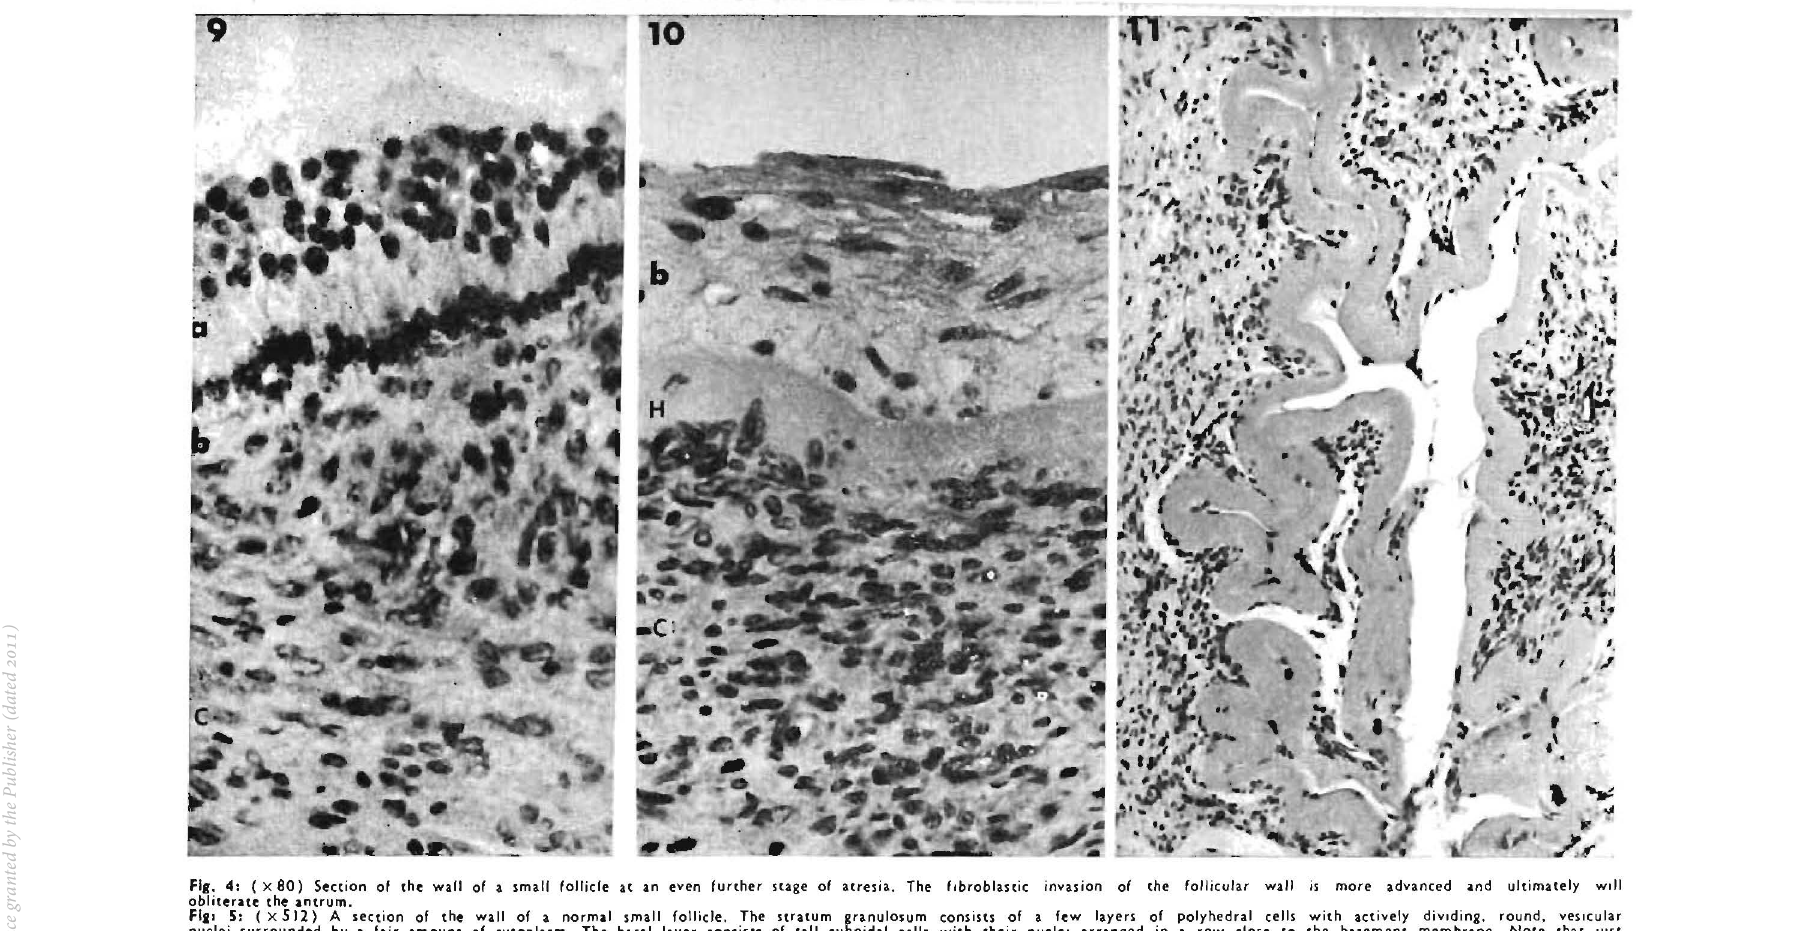
Fig. 4: (x 80) Section of the wall of a small follicle at an even further stage of atresia. The fibroblastic invasion of the follicular wall is more advanced ;and ultimately will obliterate the antrum. Fill 5: (x 512) A section of the wall of a normal small follicle. The stratum granulosum consists of a few layers of polyhedral cells with actively dividing, round. vesicular nuclei surrounded by a fair amount of cytoplasm. The basal layer consists of tall cuboidal cells with their nuclei arranged in a row close to the basement membrane. Note that JUst under these cells a few stromal thecal cells have begun differentiating into theca interna cells with large vesicular nuclei. .. Fir. 7: (x 512) Sloughing of the gr.nufos. cell. to form the pyknotic .tretic bodies ("row) flo .. in~ in the foillcul.r fluid. Fl •. 8: (x 512) A higher magnification of Fig. 3 to show the active proliferation of the thecal stromal fibroblasts and invasion of the remaining stratum granulosum. Fl •. 9: (x 512) A section of the wall of a medium-sized. normally growing follicle. Note the well-differentiated stratum granulosum (a), theca interna (b), and theca externa